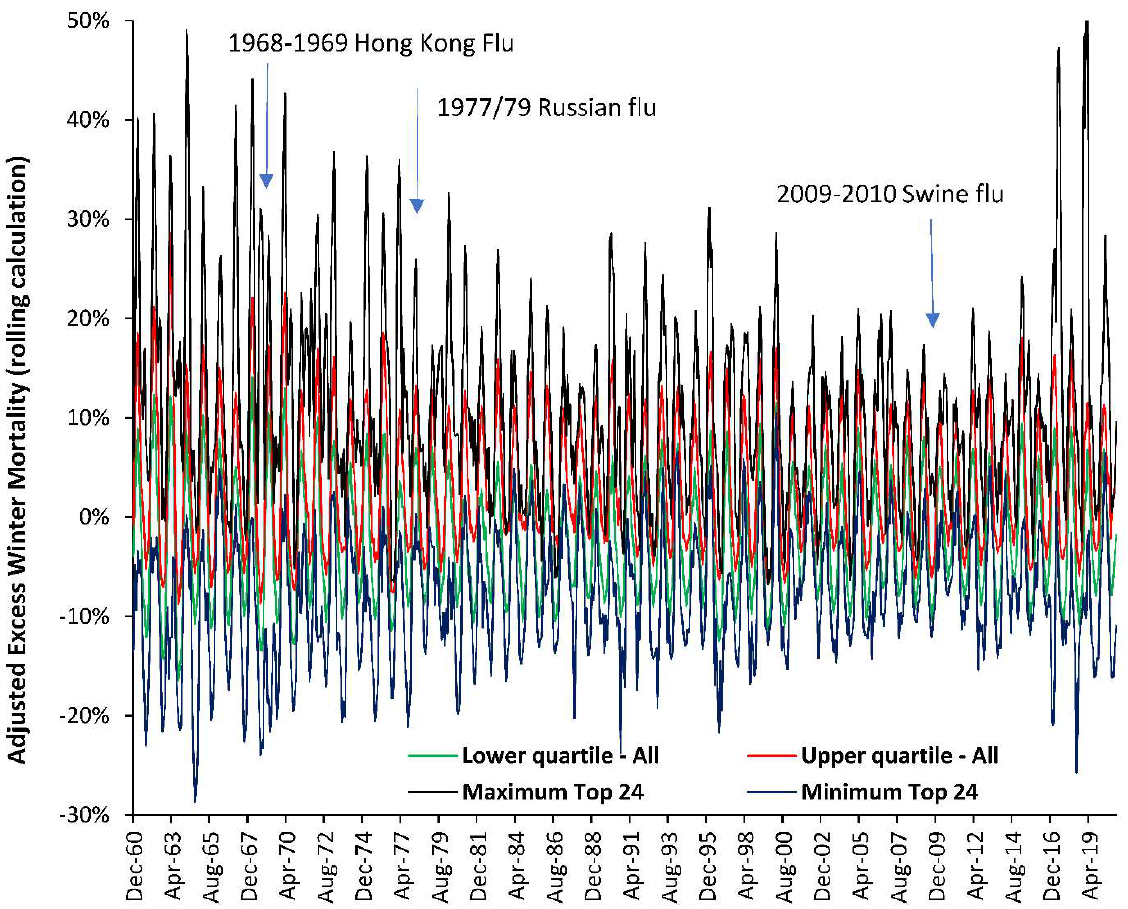
Figure 4. Trend in adjusted EWM for 25 countries (1960 to 2020) plus up to 113 countries and a further 34 states/provinces from Australia, Canada, and Germany (1980 to 2020). Countries are from both the northern and southern hemisphere.